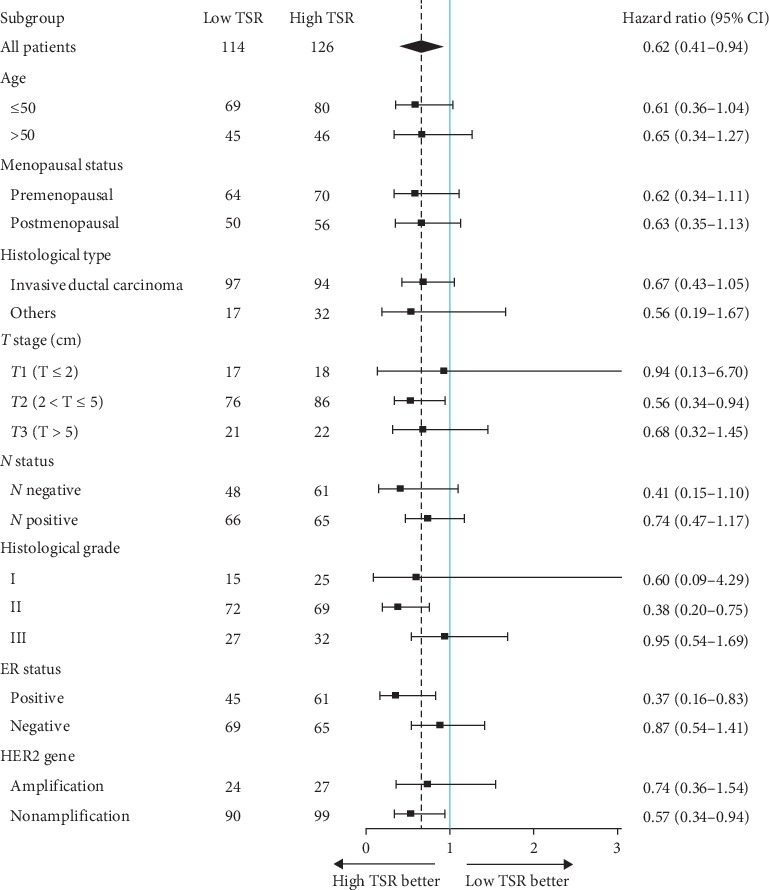
Forest plots of the TSR for association with 5-DFS in each subgroup. The dashed line showed the hazard ratio of 0.62 in all patients. CI = confidence interval.